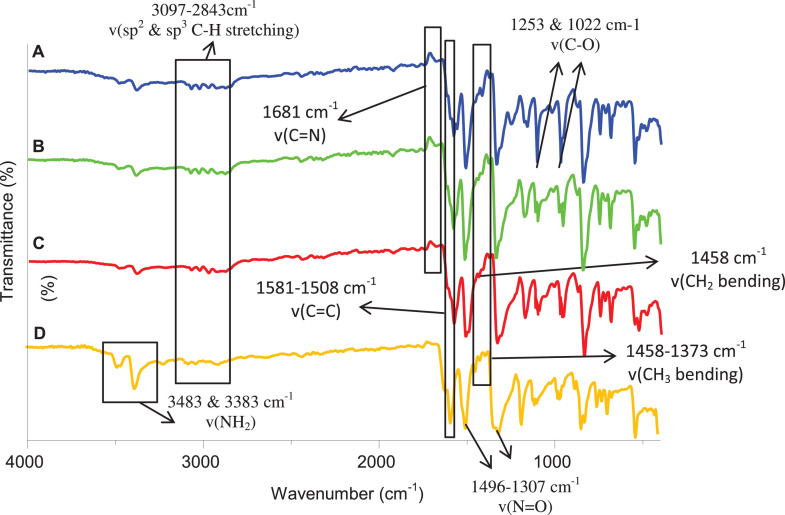
Infrared spectra of compounds formed. (A) Heck 1, (B) NO2Et, (C) NO2Me and (D) NO2OMe.